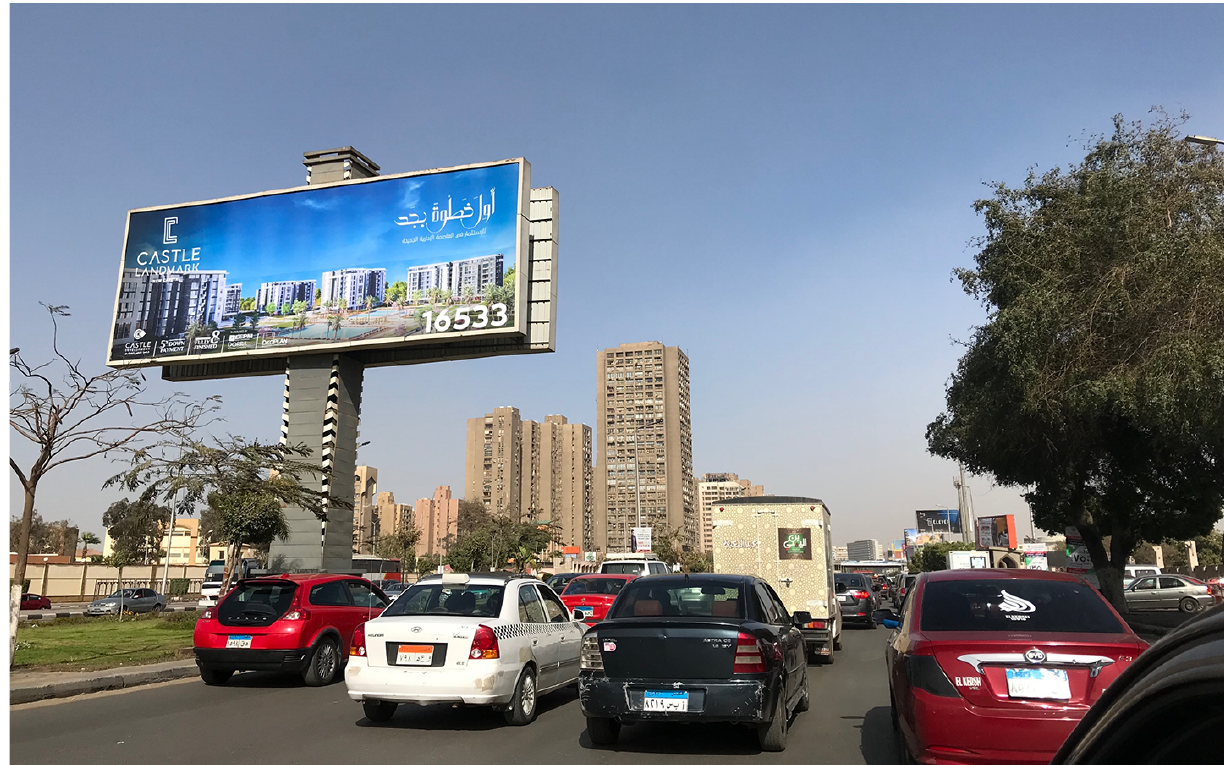
Figure 1. Two billboards on Salah Salem road in Cairo. Source: Hendawy & Saeed